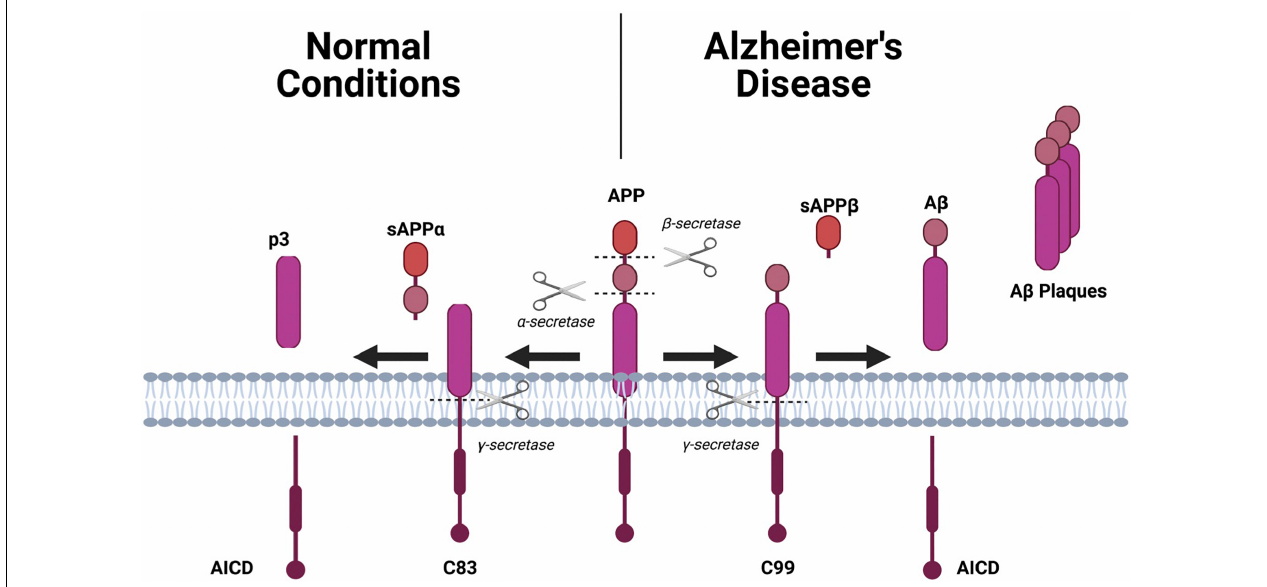
FIGURE 1 | The amyloid precursor protein (APP) will undergo one of two different hydrolysis pathways. Normal Condition: Sequential cleavage of APP by α -secretase and γ -secretase generates a soluble amino terminal ectodomain of APP (sAPP α ), the carboxy terminal fragment C83, APP intracellular domain (AICD) and a short fragment p3. Alzheimer’s Disease: Sequential cleavage of APP by β -secretase (BACE1) and γ -secretase generates sAPP β , C99, AICD and A β